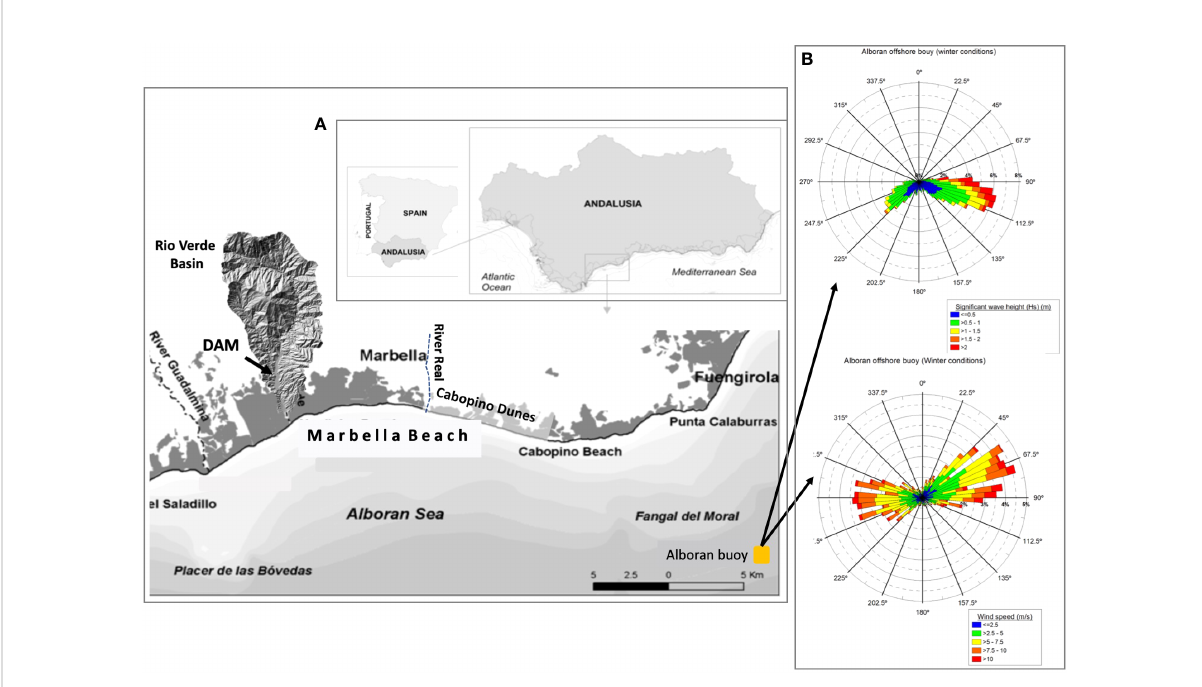
FIGURE 1 (A) Map of the study area shows the location of the embayment. The river basin of Rio Verde is drawn to indicate the scale of the basin, which has been modeled for sediment production and is interrupted by the La Concepcio ́ n dam. (B) Wave rises in winter from Alboran Sea wave buoys illustrate the intense bi-directionality of wind